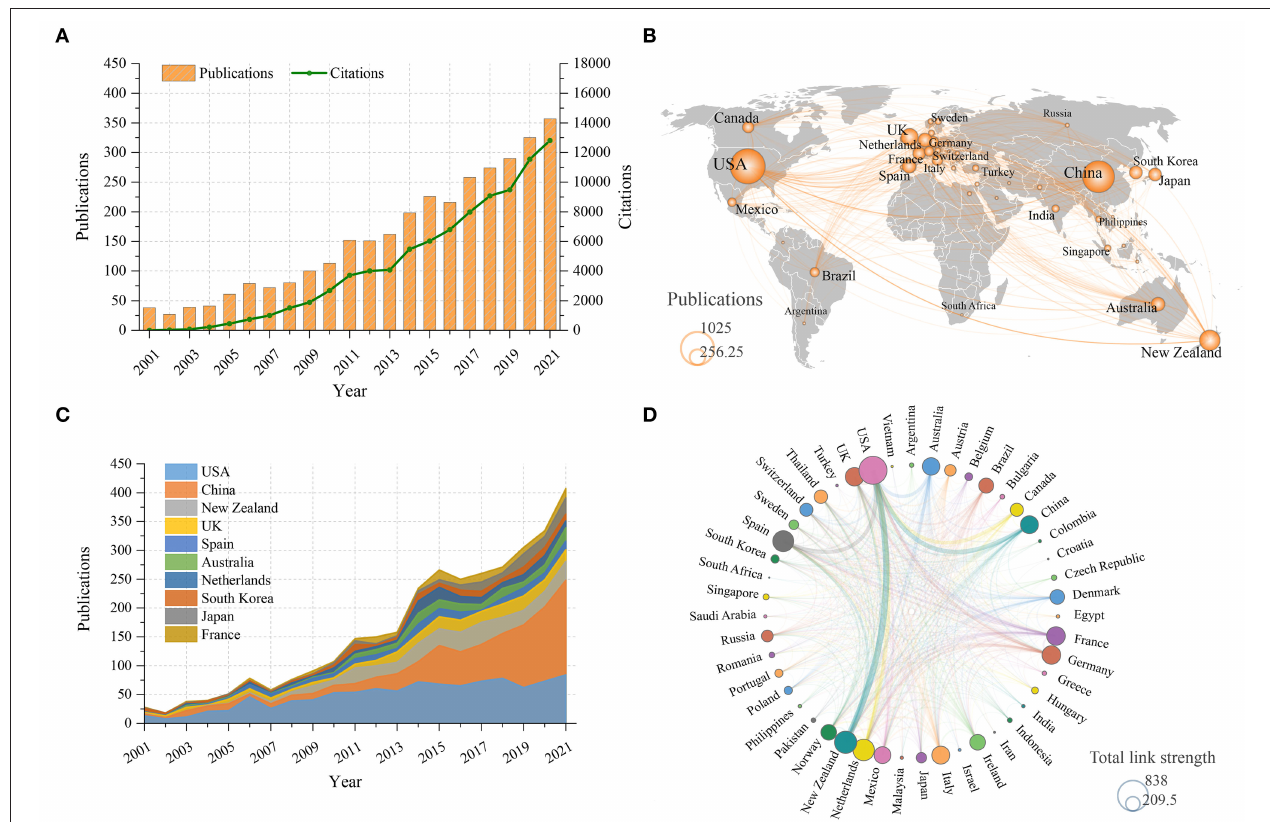
FIGURE 2 | (A) Trends in annual citations and publications about gout from 2001 to 2021. (B) World map showing the contribution of each country. (C) Trends in annual publication count in the top 10 productive countries. (D) Cooperation network among countries. The thickness of lines between two countries indicates the strength of cooperation.